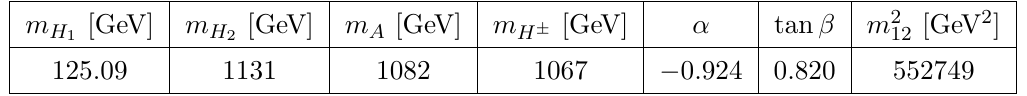
, c and g H 2 H 1 H 1 values together H 2 tt 3 production including the resonance 2 H 2